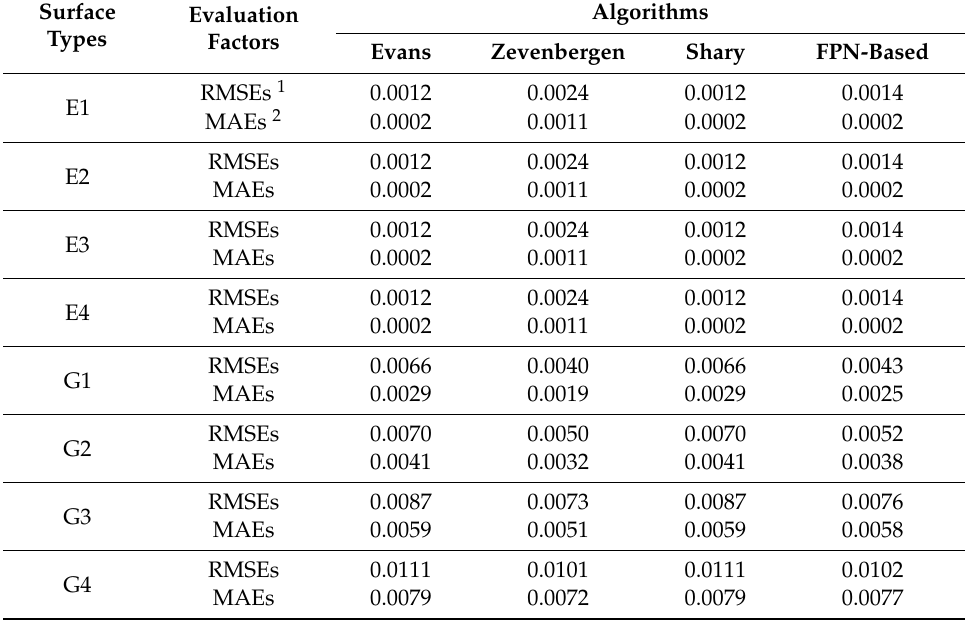
Table 5. RMSEs and MAEs for the C calculated by the comparison algorithms and proposed algorithm on the eight surfaces, except for the error on the